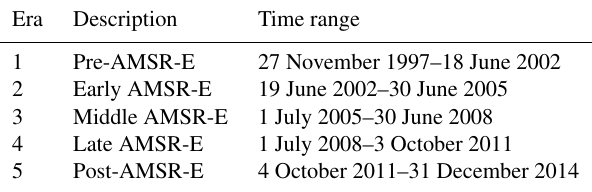
Table 1. Observation eras from 1997 to